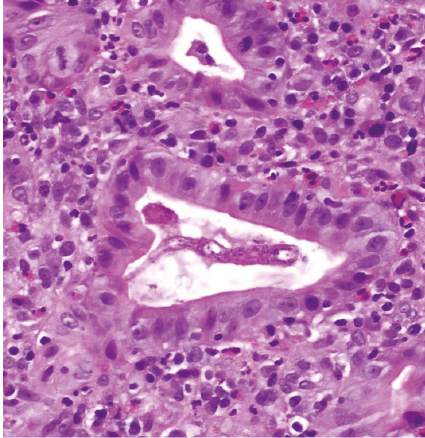
Figure 5: Strongyloides larva in the lumen of a crypt. H&E